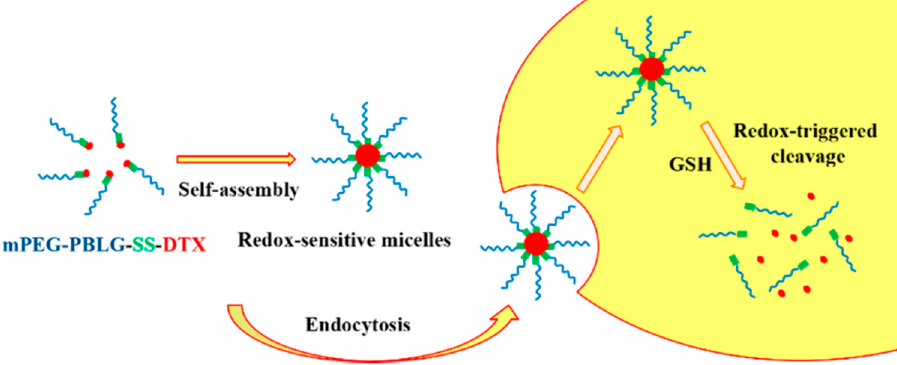
Figure 11. mPEG-PBLG-SS-DTXs Micelle Self-Assembly, Endocytosis by Tumor Cells, and Redox- Triggered Drug Release